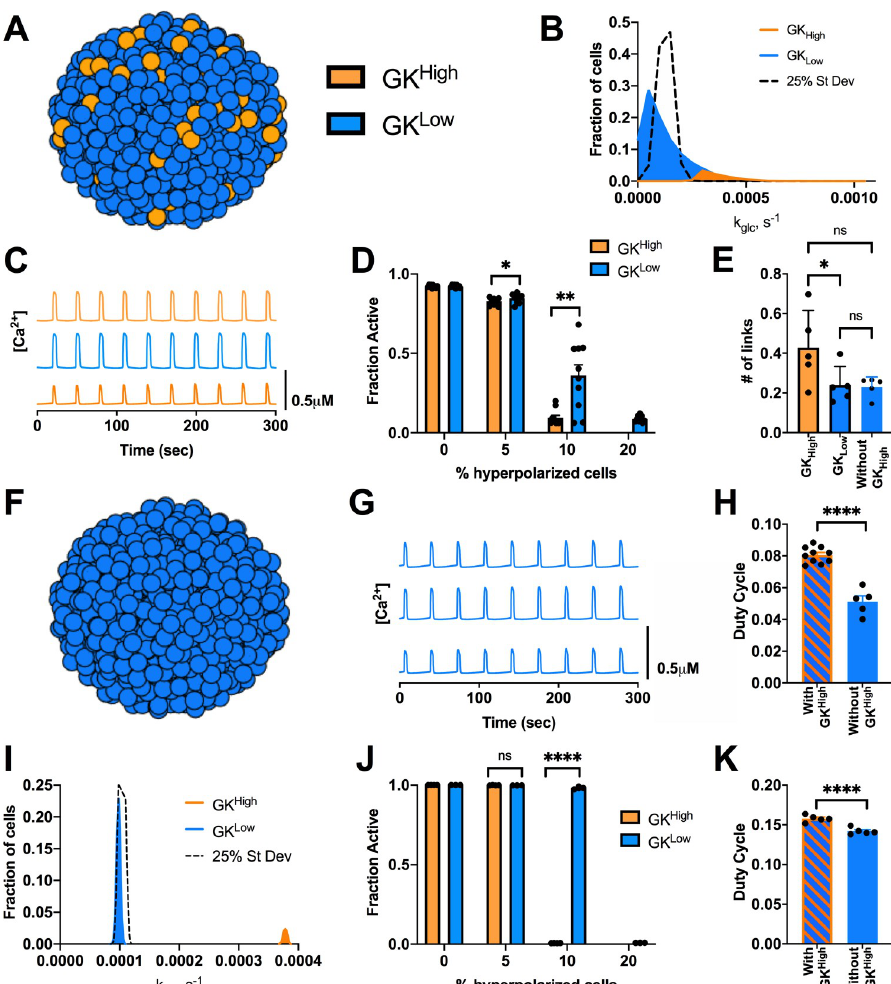
Fig 2. Alternative distributions in GK activity predicts small highly functional cells are dispensable for islet [Ca 2+ ] dynamics. A). Schematic of altered distributions of GK activity across simulated islet. B). Histogram showing average frequency of cells at varying GK rate (k glc ) for skewed distribution compared with normal distribution (25% St Dev). C). Representative time courses of [Ca 2+ ] for 3 cells in simulated skewed islet in A. Blue traces are cells from GK Low population and orange traces are cells from GK High population. D). Fraction of cells showing elevated [Ca 2+ ] activity (active cells) in skewed simulations vs. the percentage of cells hyperpolarized in islet. Hyperpolarized cells are chosen either from GK High (orange bars) or GK Low (blue bars) population. E). # of links from network analysis of [Ca 2+ ] activity for simulations with skewed distribution of GK F). Schematic of simulation where only GK Low cells are present and no GK High cells are included. G). Representative time courses of [Ca 2+ ] for 3 cells in simulated islet in F. H). Average duty cycle of cells from simulations of a skewed distribution model as in A (With GK High ) and from simulations as in F (Without GK High ). I). As in B. for bimodal distribution in GK activity where the populations only have 2.5% variation in GK activity. J). As in D. for bimodal distribution in GK activity. K). As in H. but for simulations with no GK High from a bimodal distribution. Error bars are mean ± s.e.m. Student’s paired t-test was performed to test for significance. Significance values: ns indicates not significant (p > .05), � indicates significant difference (p < .05), �� indicates significant difference (p < .01), ��� indicates significant difference (p < .001), ���� indicates significant difference (p < .0001). Data representative of 4–9 simulations with differing random number